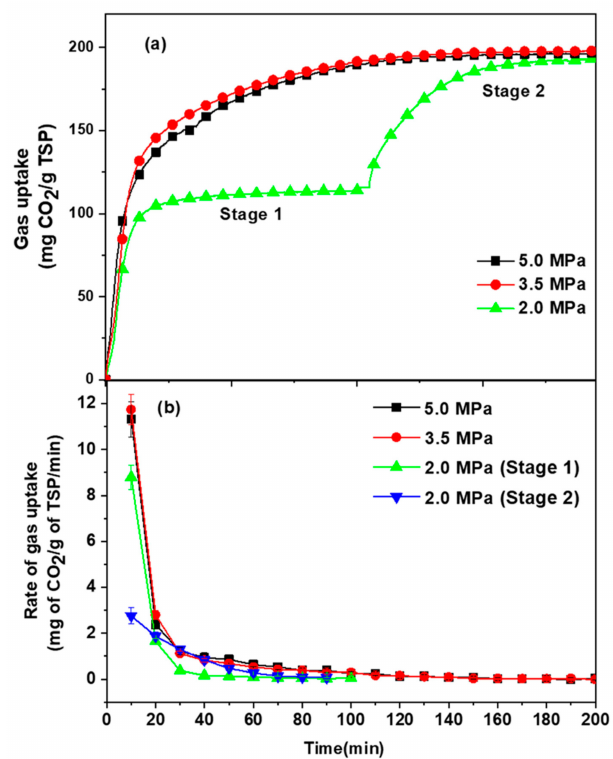
Figure 5. ( a ) Comparison of CO 2 uptake capacity (mg of CO 2 / g of sorbent) at di ff erent pressure (2.0, 3.0, and 5.0 MPa) and 30 ◦ C temperature; ( b ) rate of gas uptake (mg of CO 2 / g of sorbent / min) for the same system (Curves provided to guide the